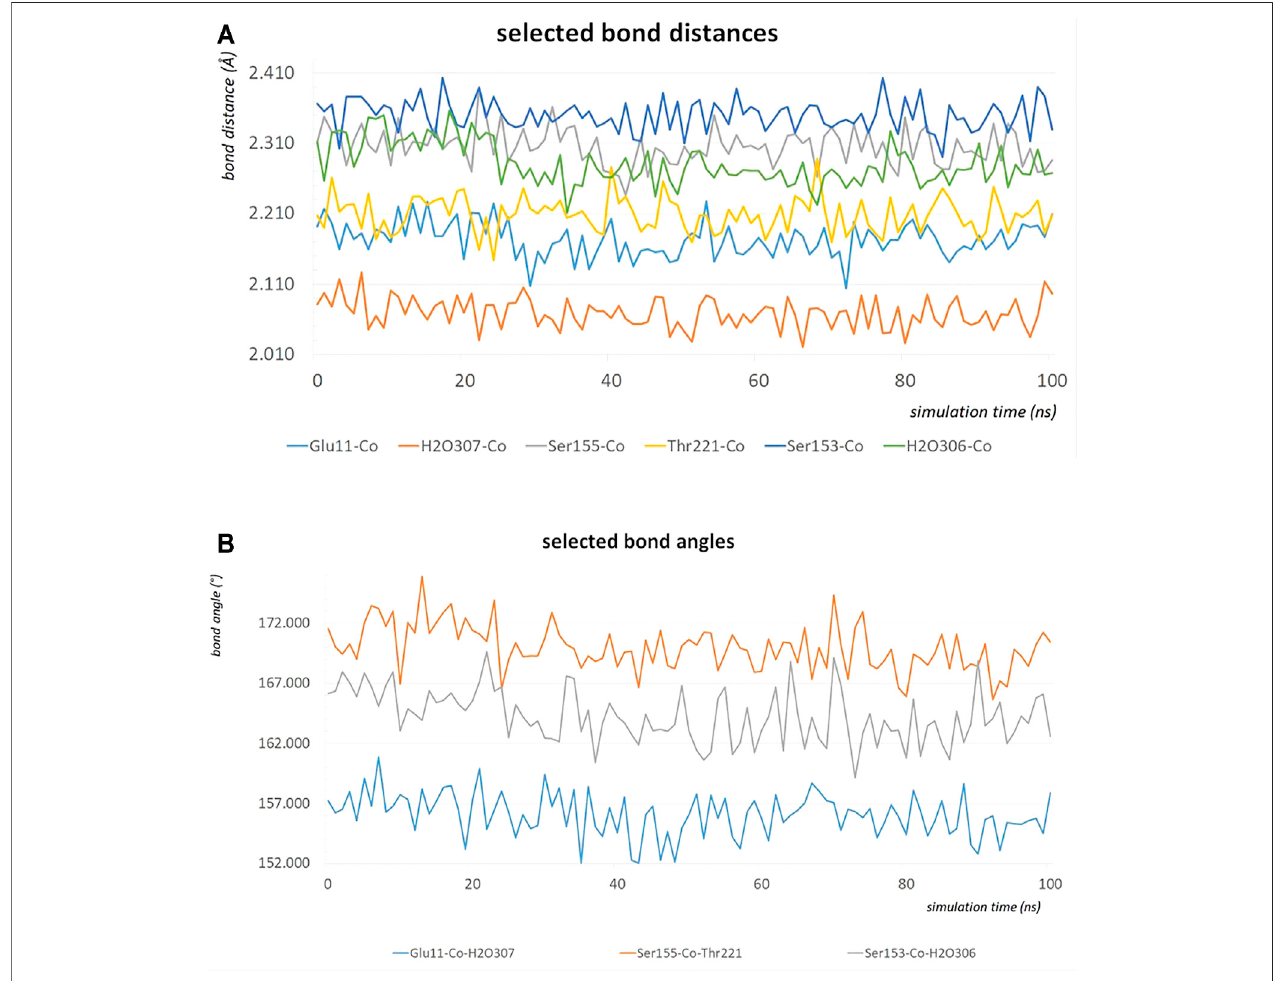
FIGURE8| ThebonddistancesinÅoftheaminoacidsSerA153,SerA155,ThrA221,GluC11,water306andwater307aroundtheCo 2+ duringanMDsimulation of 100ns (A) . The bond angles in degrees ofGlu C11-Co 2+ -water 307, Ser A155-Co 2+ -Thr A221 and Ser A153-Co 2+ -water 306during anMD simulation of100 ns (B) .